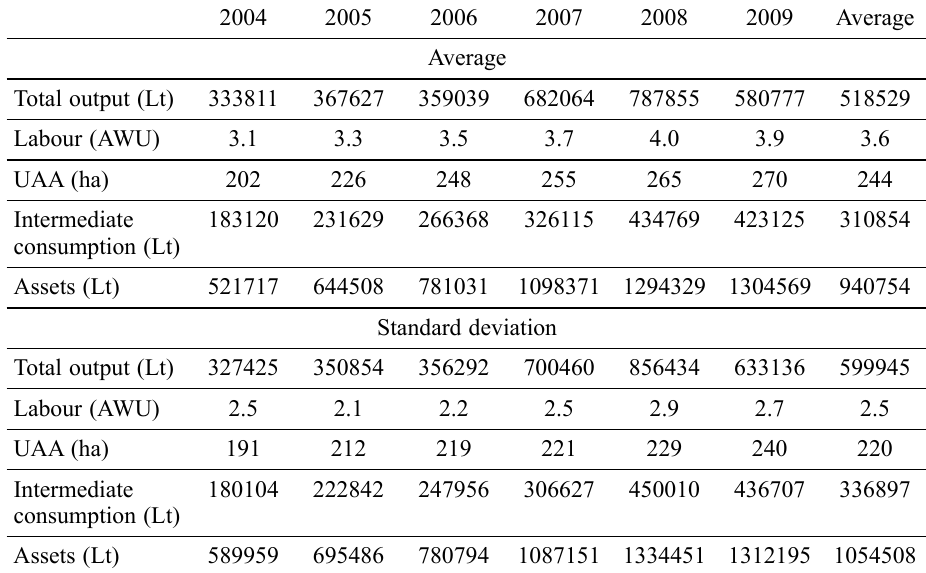
Table 1. Descriptive statistics of the analysed